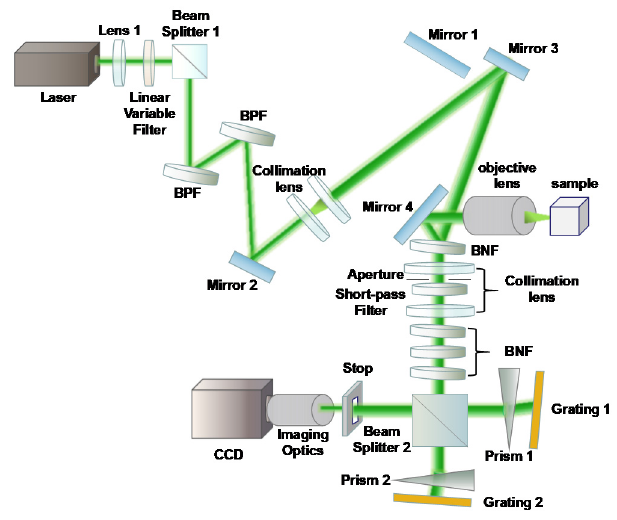
Figure 1. Optical structure of the spatial heterodyne THz Raman spectrometer.